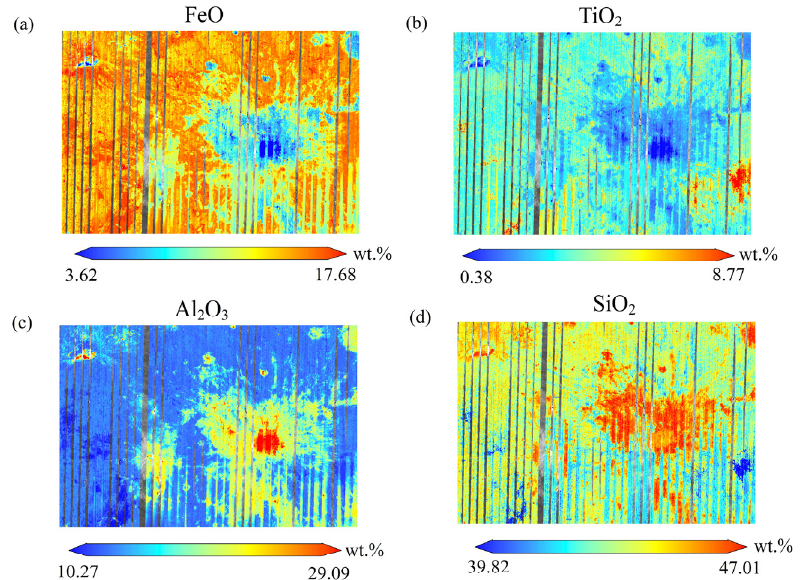
Figure 13. Predicted results of oxide contents in the study area: ( a ) FeO, ( b ) TiO 2 , ( c ) Al 2 O 3 and ( d ) SiO 2 .